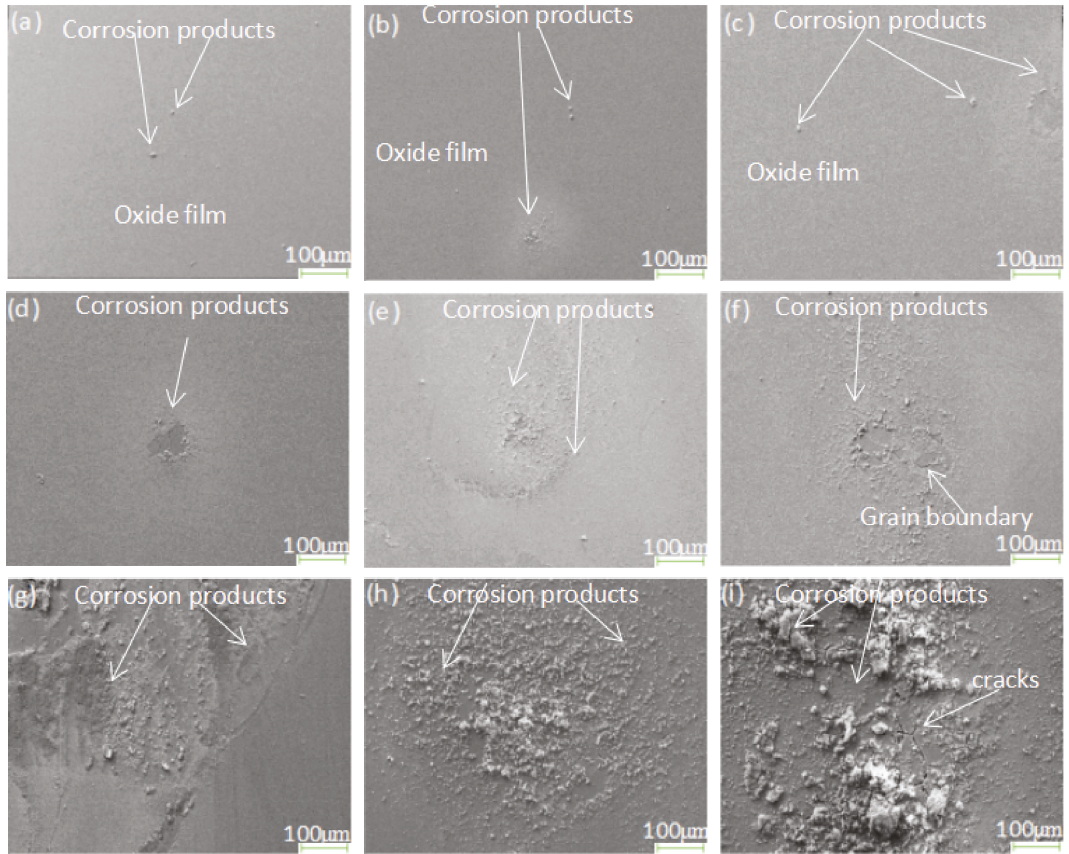
Figure 7: SEM images of corrosion product of 2060 Al–Li alloy after salt spray corrosion at different times: (a) 1, (b) 2, (c) 4, (d) 8, (e) 16, (f) 24, (g) 32, (h) 48, and (i)